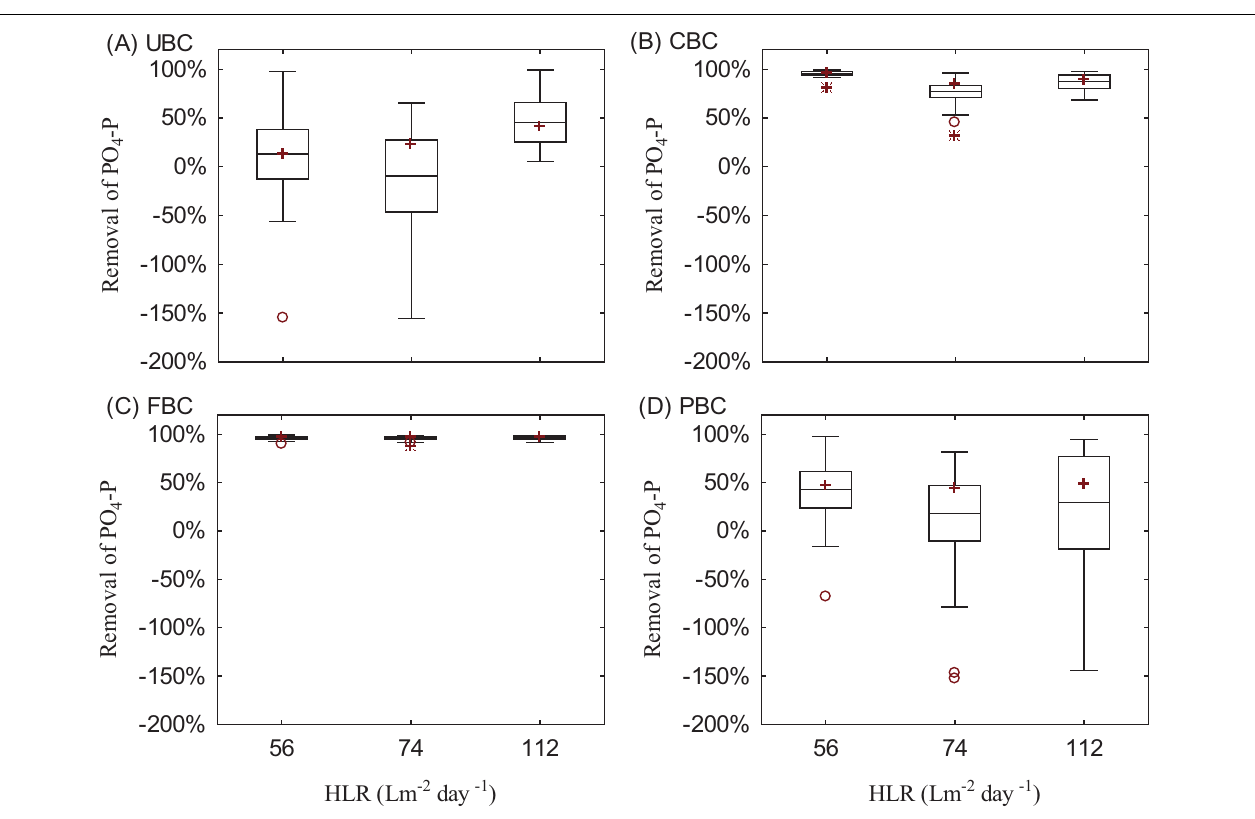
FIGURE 5 | Boxplots showing removal of phosphate-phosphorus (PO 4 -P, %) in (A) unimpregnated biochar filter (UBC), (B) CaO-impregnated biochar filter (CBC), (C) FeCl 3 -impregnated biochar filter (FBC), and (D) biochar filter mixed with Polonite R (cid:13) (PBC) for different hydraulic loading rates (HLR). The middle line (–) of the box is the mean, the cross (+) is the median, the box is the confidence interval, the whiskers are the non-outlier range, and the red dots are outliers and extreme values.